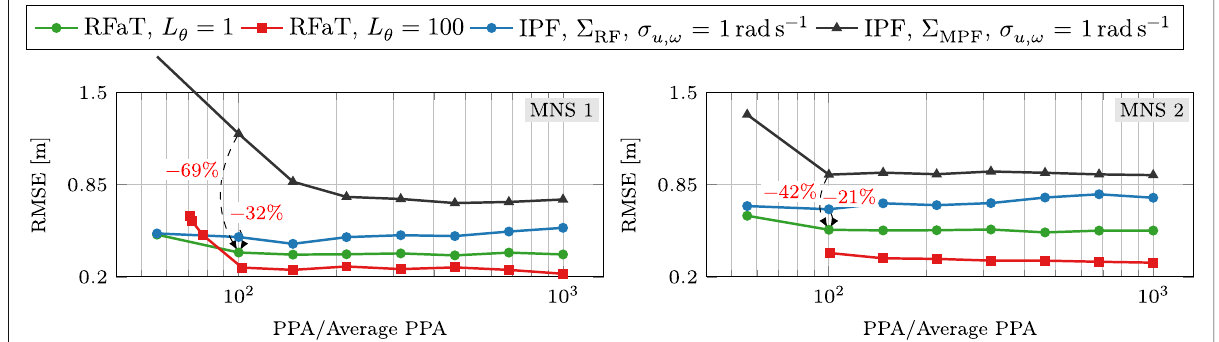
Fig. 10 Comparison between the RFaT and IPF algorithms for varying state PPA values. The left panel shows the results for MNS 1, and the right panel shows the results for MNS 2